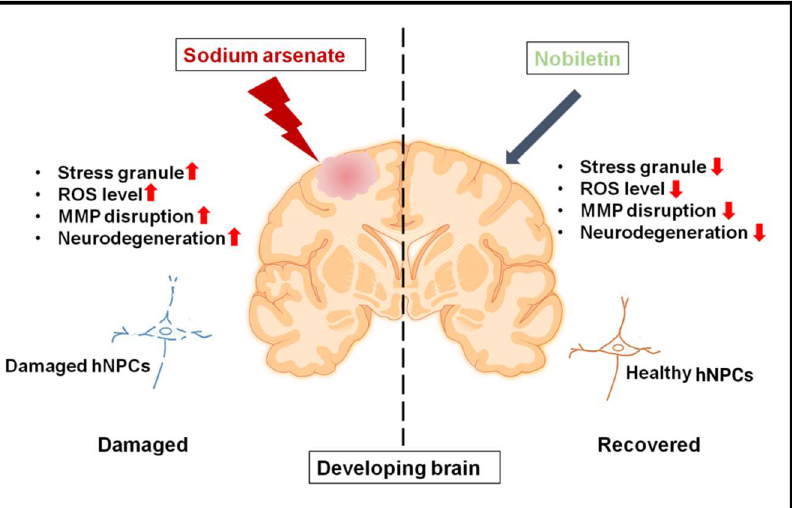
Figure 8. Schematic representation of NA-induced neuronal damage and the neuroprotective efficacy of NOB on human neural progenitor cells (hNPCs). (Figure Created with BioRender.com (accessed on April 19th, 2022).